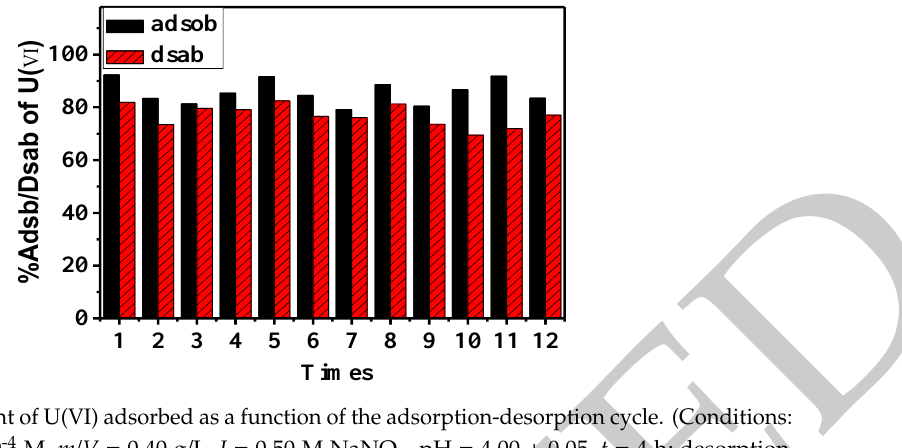
Figure 15. The amount of U(VI) adsorbed as a function of the adsorption-desorption cycle. (Conditions: [U(VI)] 0 = 4.1240×10 -4 M, m / V = 0.40 g/L, I = 0.50 M NaNO 3 , pH = 4.00 ± 0.05, t = 4 h; desorption eluent = 0.10 M HNO 3 .